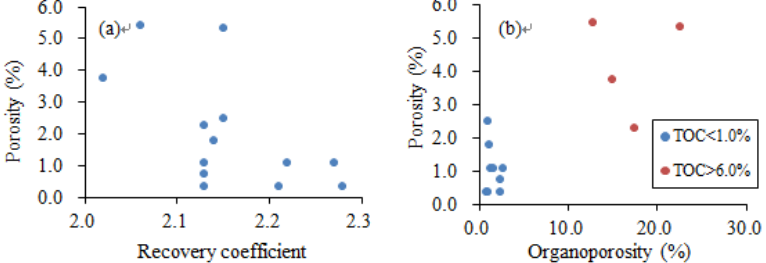
Figure 10. ( a ) Relationship between porosity and recovery coefficient; ( b ) relationship between porosity and organoporosity.